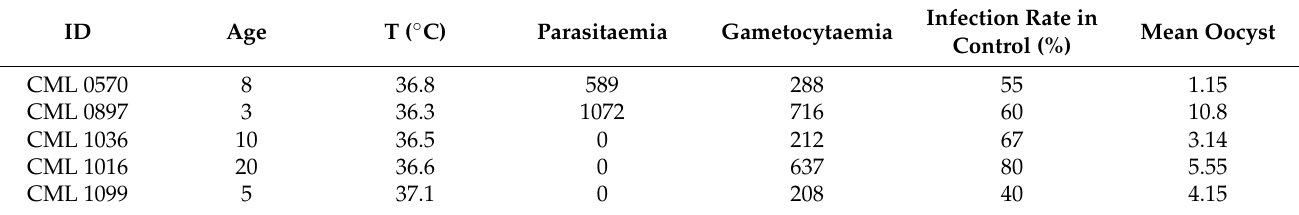
Table A1. Parasitemia and gametocytemia have been estimated by counting, respectively, the asexual and sexual stages of the parasite as described by the WHO [40]. Infection intensity (Oocyst density) and infection rate (prevalence of oocyst) were estimated by counting the oocyst in the mosquito midguts. Ni Number of mosquitoes in each treatment